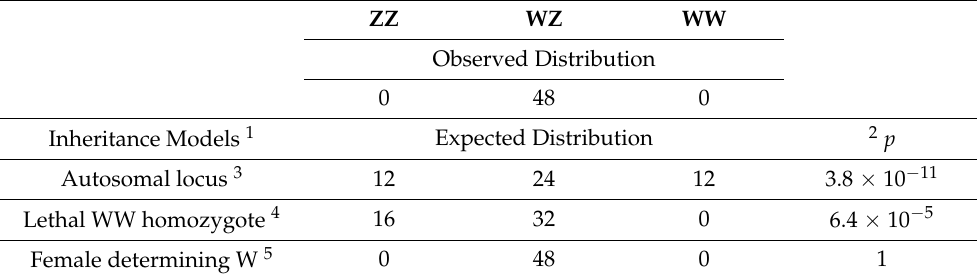
Table 4. Goodness of fit of inheritance models with the observed distribution of Z/W based on banf2 genotypes in females of Oa stock ( n =